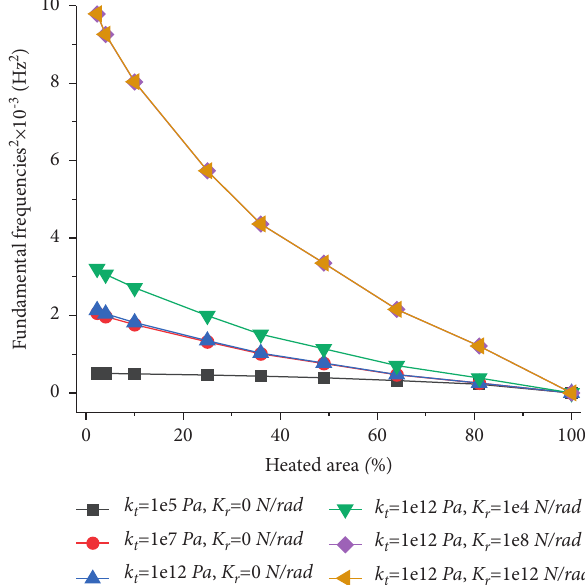
Figure 8: Fundamental frequencies of composite laminated plates with different heating